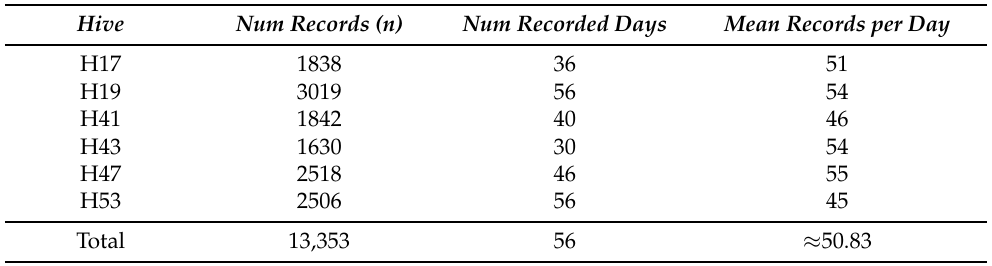
Table 1. A quantitative summary of the curated dataset; the number of records n for each hive specifies the number of time-aligned weight and traffic